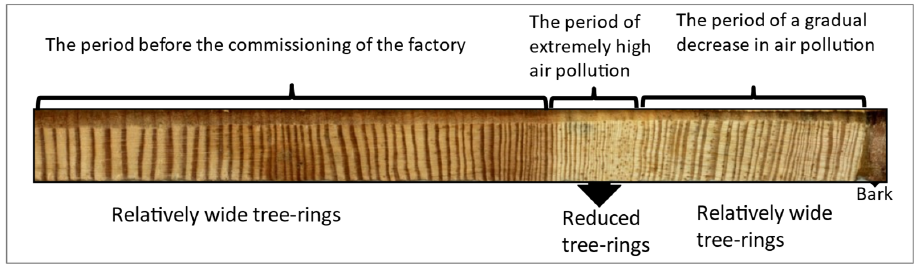
Figure 4. Illustration of a zone with reduced radial growth (sample taken from a pine growing on the 1st plot).